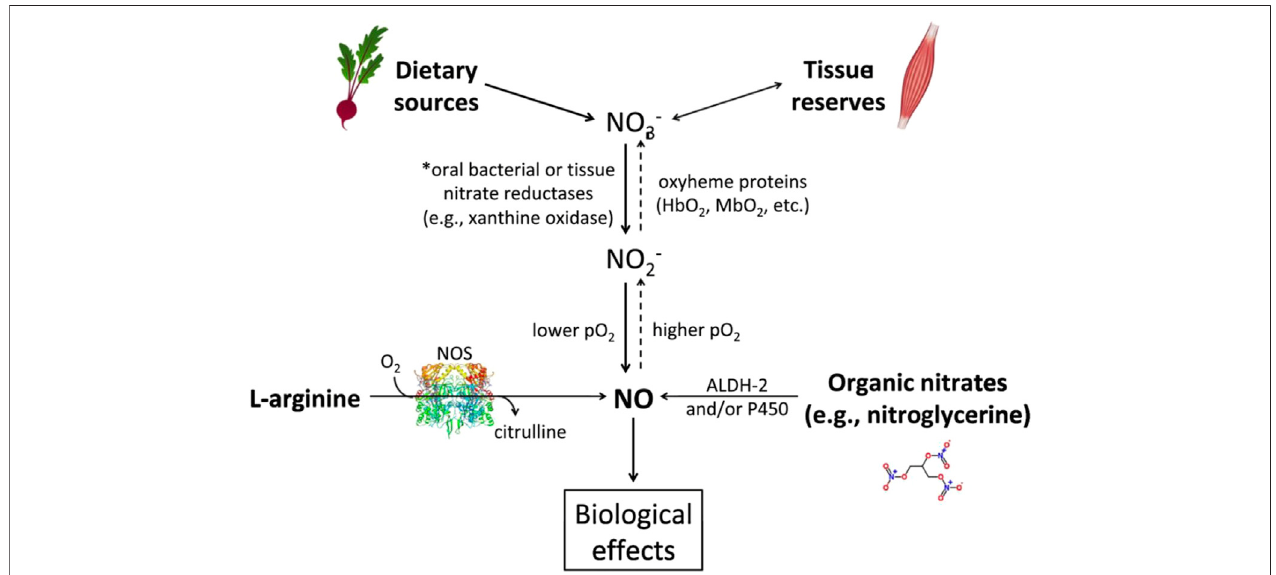
FIGURE 1 | The main pathways for nitric oxide (NO) production. The dietary pathway (starting at upper left) utilizes NO 3- and is facilitated by lower pO 2 and pH. Ingestion of NO 3 − -containing foods, especially vegetables such as beetroot, start this pathway. NO 3 − is reduced to nitrite (NO 2- ) by reductases or acidic conditions and facilitated by oxyheme proteins. Then NO 2- is reduced to NO under the appropriate conditions. Importantly, skeletal muscle can serve as a ‘ reservoir ’ for nitrate. As shown by the dashed arrows, this pathway can also ‘ run in reverse ’ with NO being used to create NO 2- and then NO 3 − given the appropriate conditions. *Note: NO 3 − can be taken up from the circulation into the salivary glands and go through this reduction pathway again in what is known as ‘ the enterosalivary pathway. ’ The endogenous pathway (lower left) uses NO synthase and oxygen to create citrulline and NO. An abbreviated depiction of the organic nitrate pathway (lower right) shows the production of NO derived from pharmacologic sources, such as nitroglycerin. ALDH-2 = aldehyde dehydrogenase, P450 = cytochrome P450. Reproduced with permission from Biochimica et Biophysica Acta (BBA) — Molecular Basis of Disease. Vol 1865, Mulkareddy V, Racette SB, Coggan AR, Peterson LR. Dietary nitrate ’ s